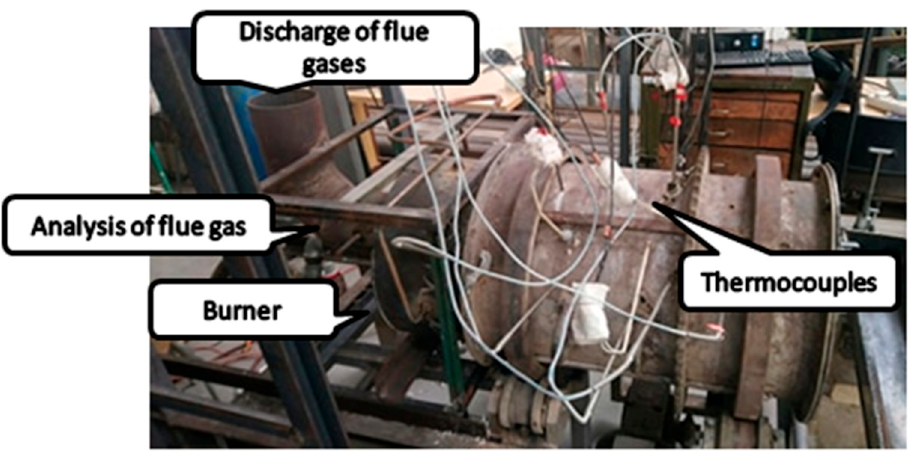
Figure 5. Experimental model of tilting rotary kiln.